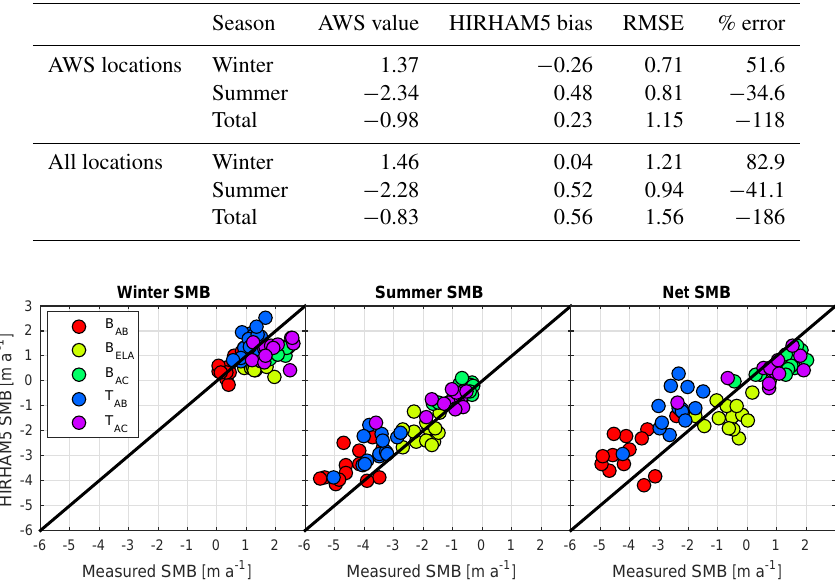
Figure 7. Comparison of the winter, summer, and net mass balance from the period 1995–2014 between the mass balance measurements at the five AWS sites and the HIRHAM5